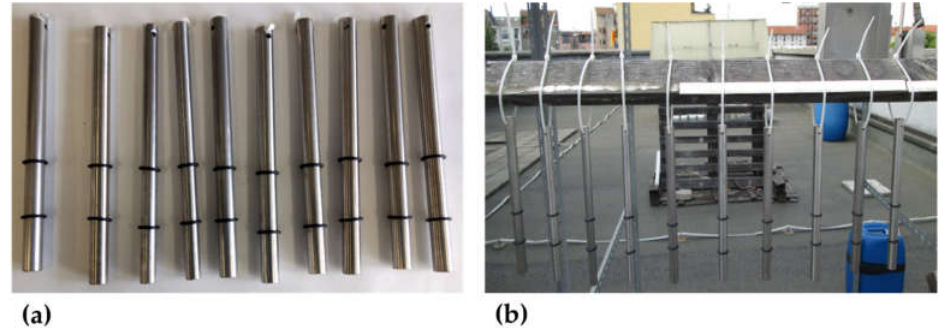
Figure 4. Samples exposed to ( a ) urban atmosphere at time zero and ( b ) urban atmosphere after 295 days.